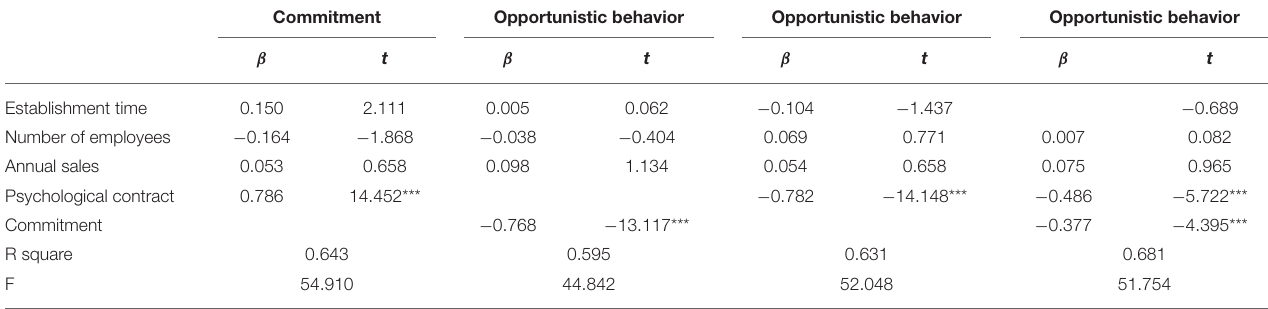
TABLE 5 | Mediation effect results of